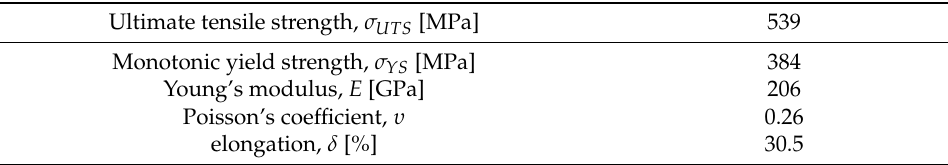
Table 2. Mechanical properties of Q345D steel.